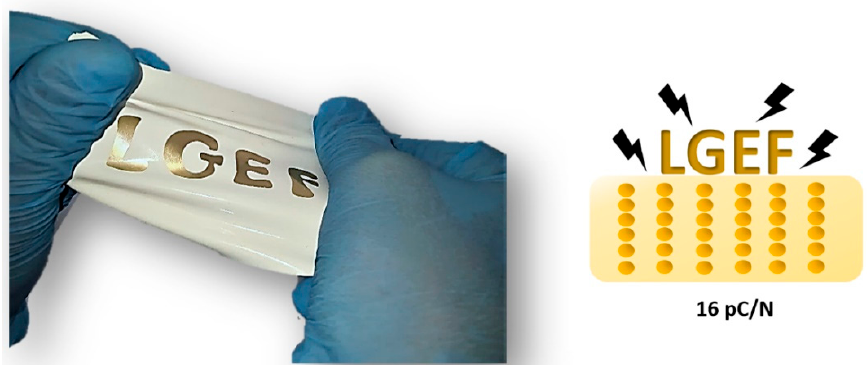
Figure 9. Picture of stretched piezoelectric sensor developed in this study.